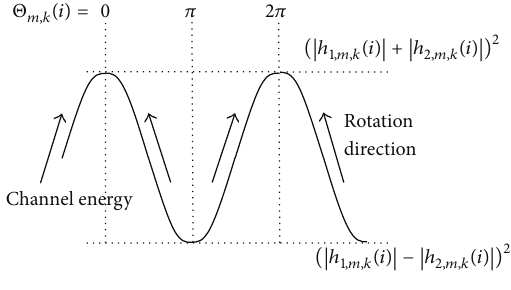
Figure 3: Rotation directions by adaptive phase